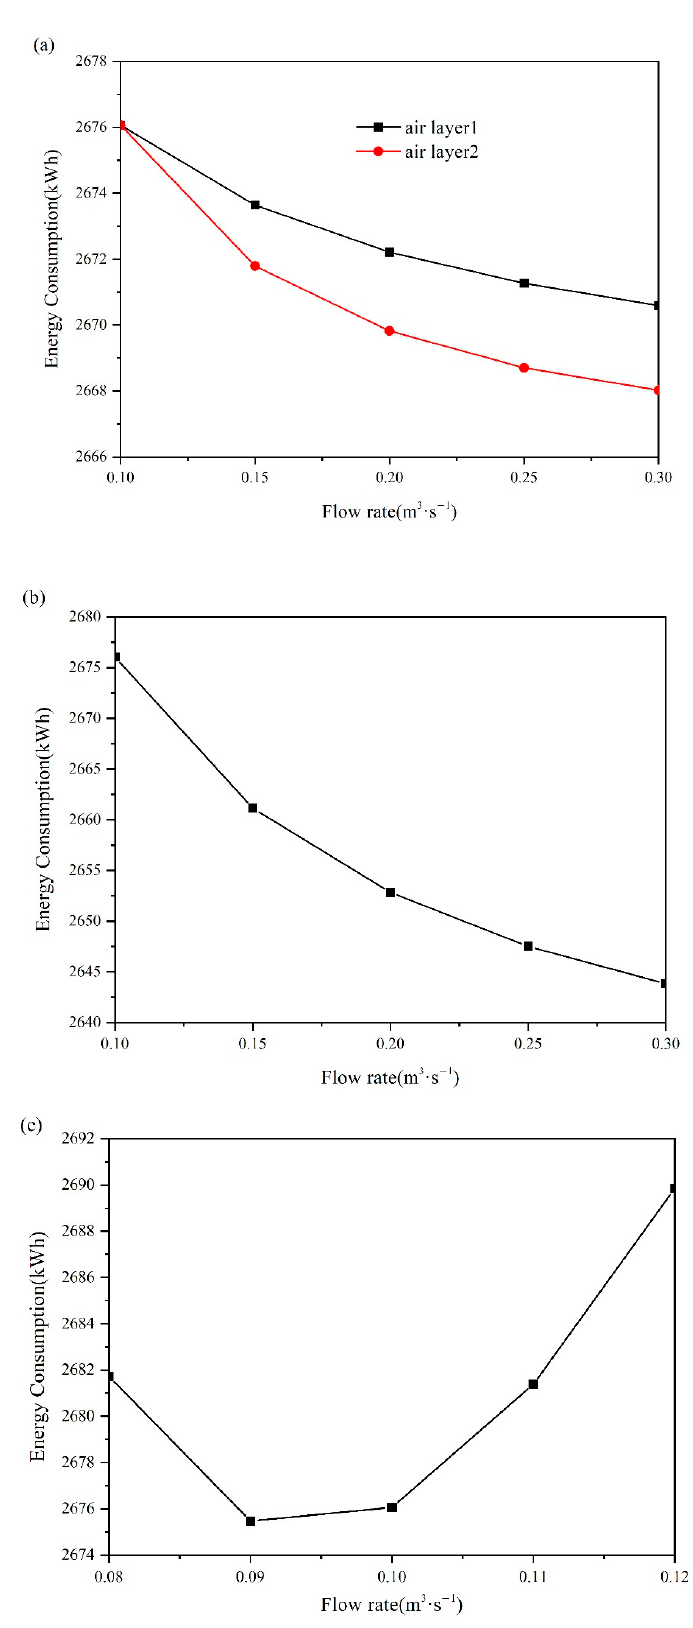
Figure 6. The energy consumption of the room when the flow rate is at different values: ( a ) air layer 1 and air layer 2; ( b ) between air layer 3 and the room; ( c ) between air layer 2, air layer 3, and the room.